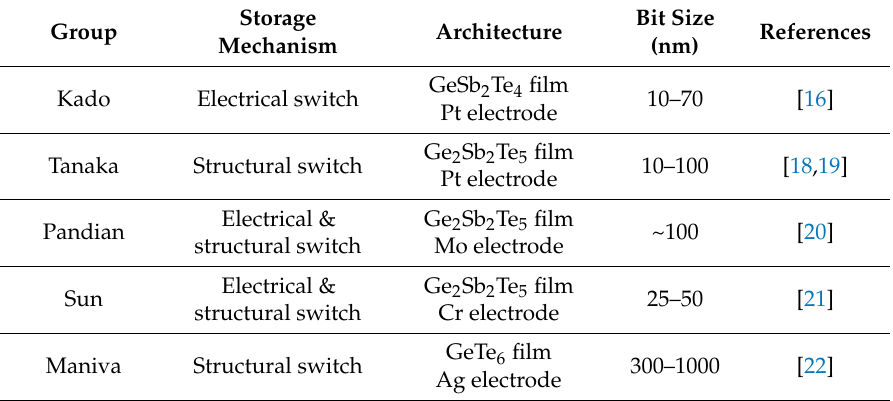
Table 1. Characteristics of probe-sample device to switch PCMs.